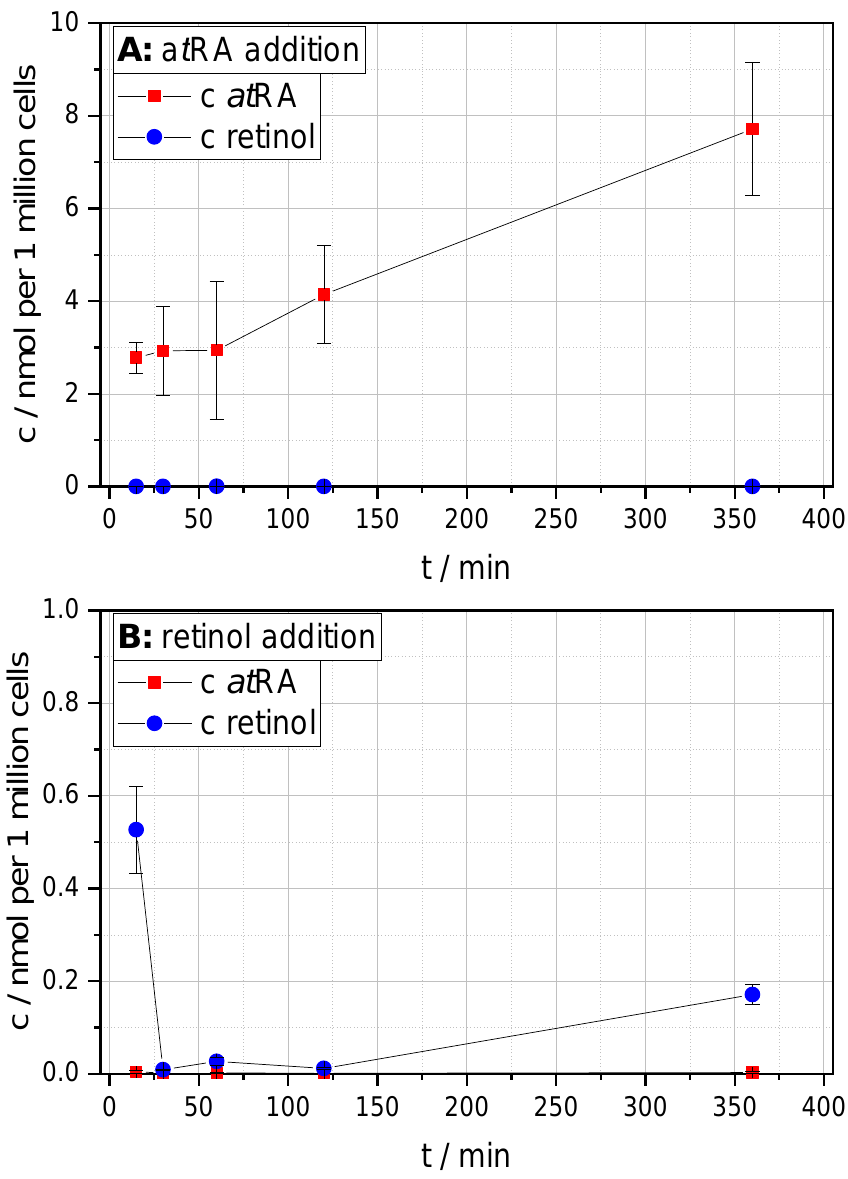
Figure 5. Results of the in vitro tests measuring the uptakes of all- trans retinoic acid (a t RA) ( A ) and retinol ( B ) by human umbilical-vein endothelial cells (HUVECs) under hypoxic conditions at various time points. The error bars represent the standard deviation of the results of biological triplicates.